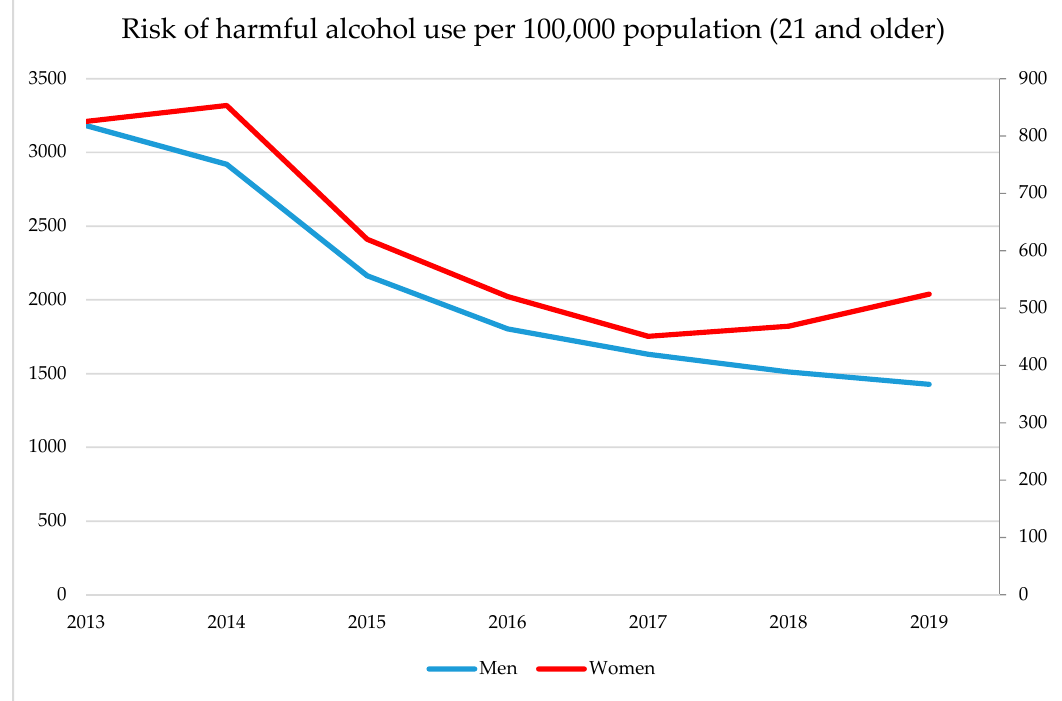
Figure 6. Age-standardized rate of harmful alcohol consumption per 100,000 population (aged 21 and older), defined as a score of ≥ 2 according to the CAGE screening tool (until 2018) and as ≥ 3 for women and ≥ 4 for men for AUDIT-C (starting from 2018). Left scale: men, right scale: women. Source: National Medical Research Center for Therapy and Preventive Medicine of the Ministry of Health of the Russian Federation.